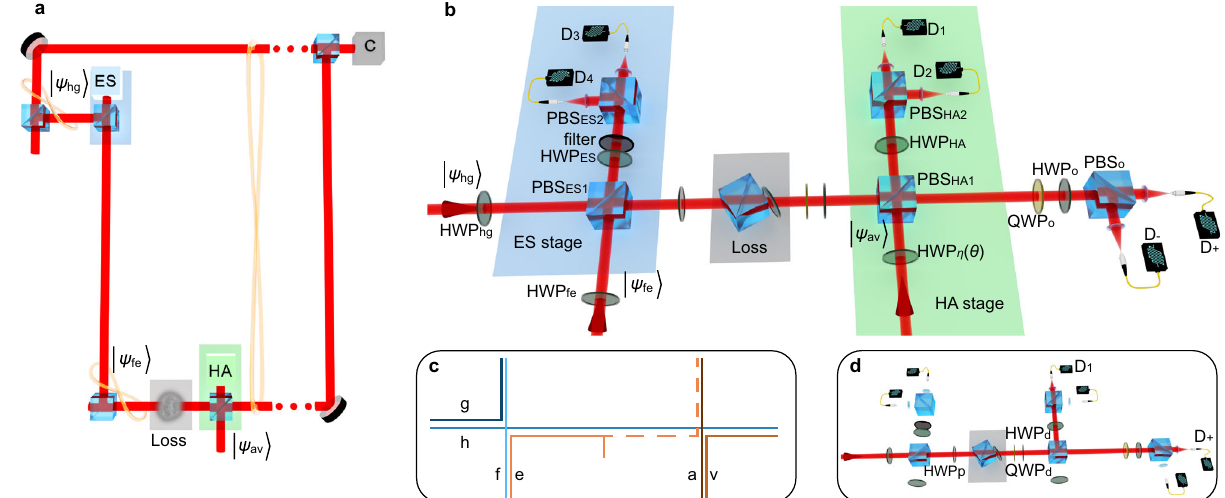
Fig. 2 Concept and layout of the experimental apparatus. a Concept of the experiment, which implements the scheme of Fig. 1d. Half of the entangled state j ψ i is teleported through a heralded corrected channel. This comprises an entangled source, loss on one mode (the distribution mode), and an HA. hg This leads to entanglement between modes “ h ” and “ v ” that, ideally, is larger than the entanglement between “ f ” and “ e ” after “ e ” goes through the lossy channel. Modes “ h ” and “ v ” are then brought together for a joint measurement to determine the concurrence C . b Experimental setup for the error- corrected quantum channel. This diagram has a one-to-one mode mapping to part a , as shown in sub fi gure c , but some of the modes are now spatially overlaid and distinguished by polarization. Blue and green backgrounds highlight ES and HA stages, respectively. Gray background highlights polarization dependent loss. Optical axes of HWP fe and HWP hg , set at π /8 with respect to the horizontal axis, prepared j ψ modes input to PBS HA2 and PBS ES2 were mixed by HWP HA and HWP ES , set at π /8. HWP η ( θ ), with optic axis orientated at angle θ , initialized the HA resource state j ψ i , with η ¼ sin ð 2 θ Þ . HA success was heralded by a single detection event in either superconducting nanowire single photon detector av (SNSPD) D 1 or D 2 and ES success was heralded by a single detection event in either D 3 or D 4 . Detectors D + and D − , together with QWP o , HWP o and PBS o were used to perform polarization state tomography on the modes “ h ” and “ v''. c Mode propagation inside the setup in case of the error-corrected channel. Mode “ h ” propagates through the setup unaffected by loss or other optical components. d Same setup but with single photon input, used to test direct transmission through loss to compare the fi nal concurrences. HWP p was set to π /8 in order to prepare j ψ detectors D + and D 1 were used to perform polarization tomography of the state after the loss. Note that the ultrahigh-heralding-ef fi ciency photon sources required for this protocol are not shown in the fi gure---see Methods for